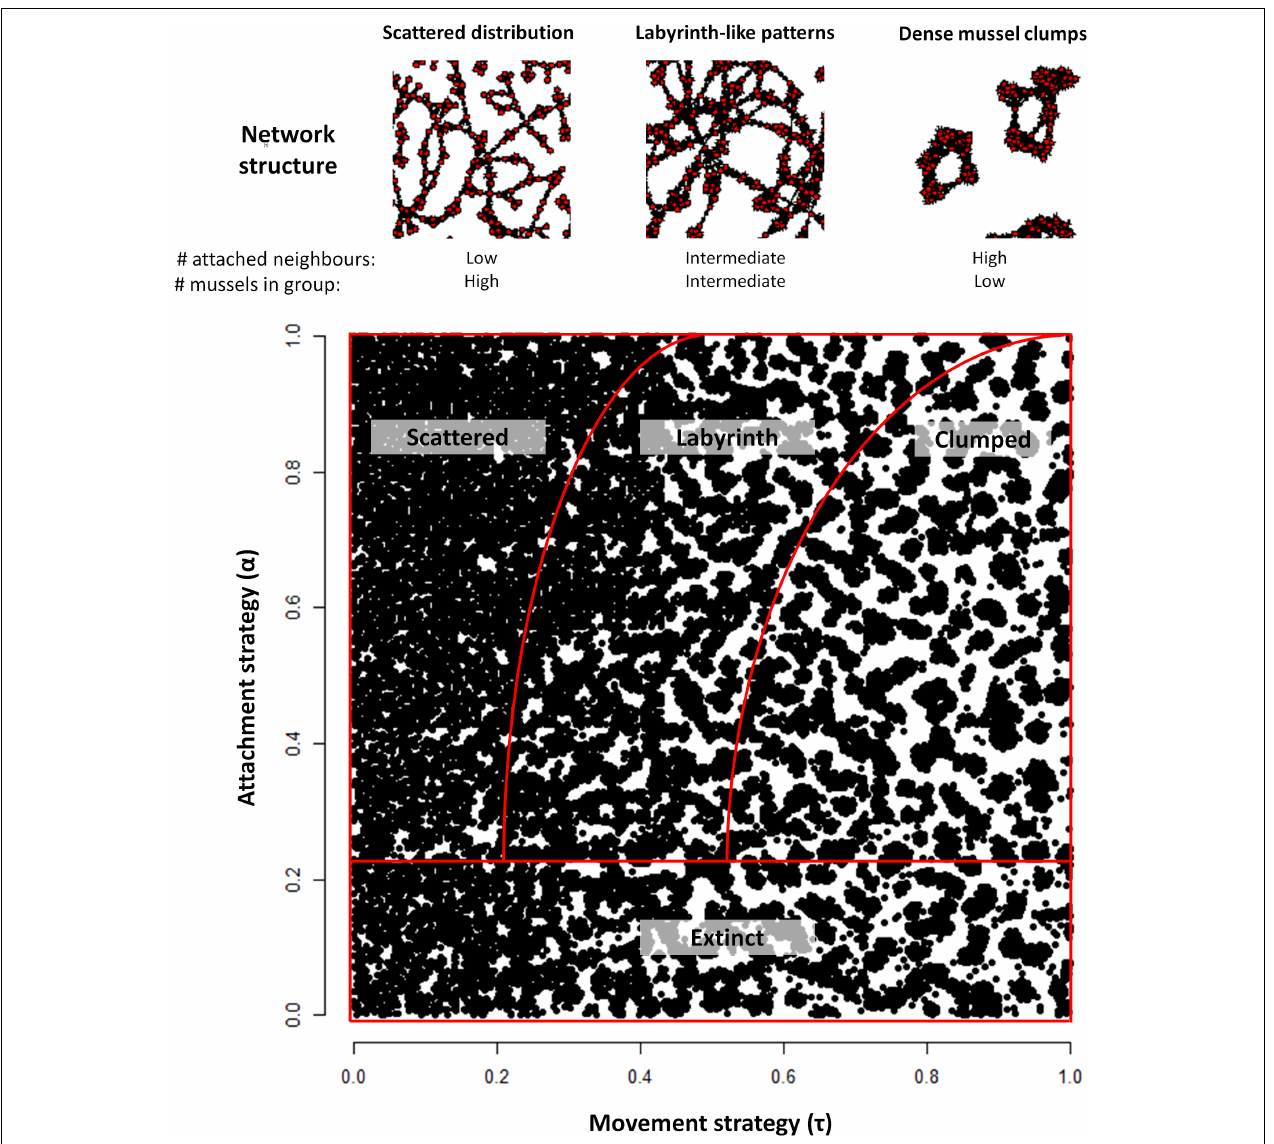
FIGURE 1 | Illustration of the cooperative network (Top) and patterns (Bottom) generated by mussel populations with different combinations of the movement threshold τ and the attachment rate α . In the cooperative networks shown in the top panels, red dots correspond to individual mussels and black arrows indicate byssal attachments. Here, α = 1. In scattered distributions, a low number of direct neighbors is attached to a mussel, while it is part of a large group. In contrast, mussels in dense clumps are attached to many direct neighbors, yet their group size is limited. In labyrinth-like patterns, both group size and number of direct attachments are intermediate, thereby compromising safety against individual-level predation and group-level dislodgement by wave stress. Different spatial patterns emerge, ranging from random distributions, to labyrinths and dense clumps, for different combinations of α and τ . When α < 0.2, the population does not survive under most levels of environmental stress. The bottom panel was created by joining the final mussel distributions of 5 · 5 simulations. As such, it holds a too large number of mussels to clearly show that scattered distributions are indeed scattered. Each black dot represents a single mussel; individual byssal attachments are not illustrated